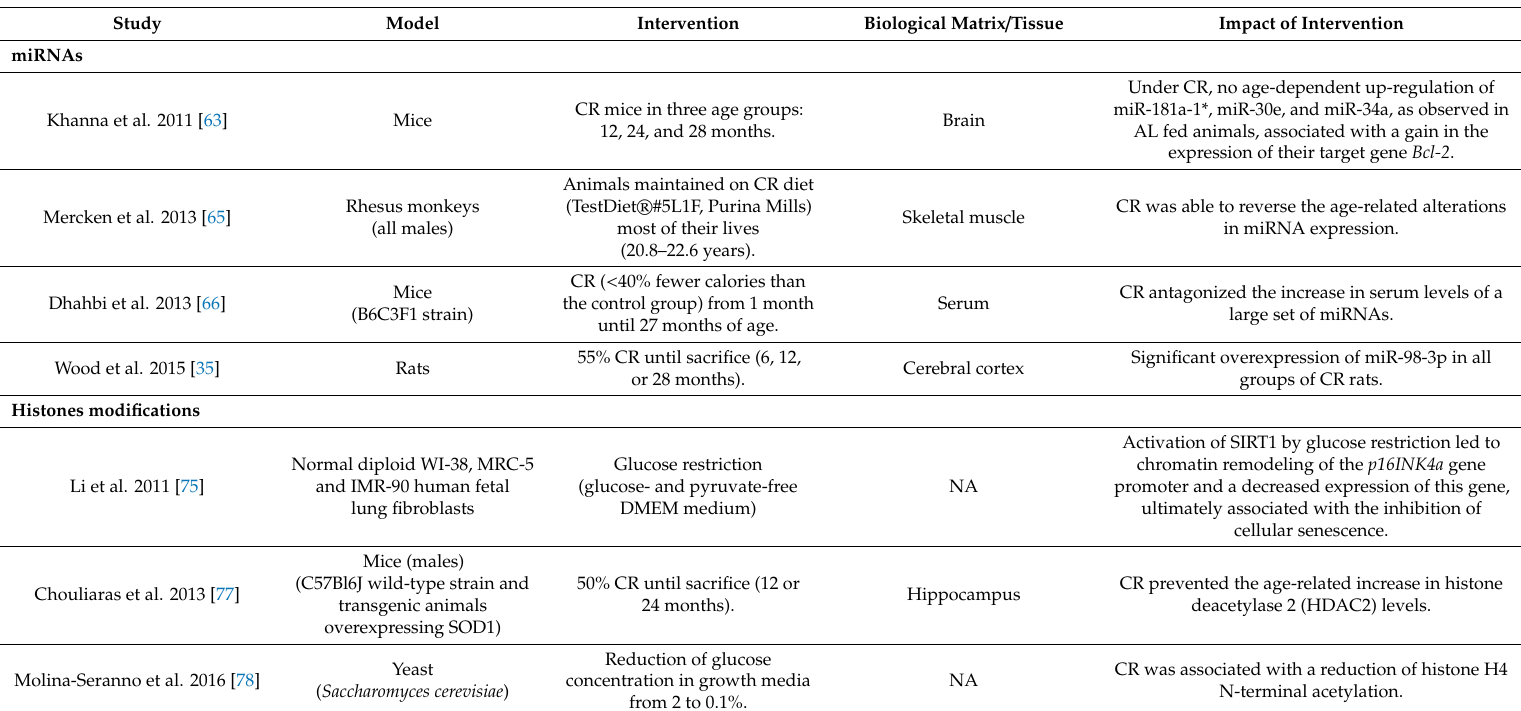
Table 1. Impact of caloric restriction on age-associated microRNAs (miRNAs) changes and histones